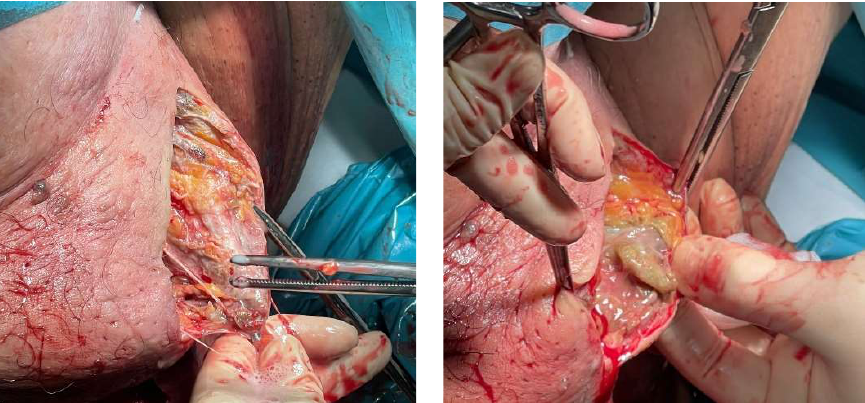
Figure 5. Necrotic tissues exposed during surgery prepared for debridement. The surgical technique involves removing as much death tissue as possible, leaving open wound to oxygenate it.